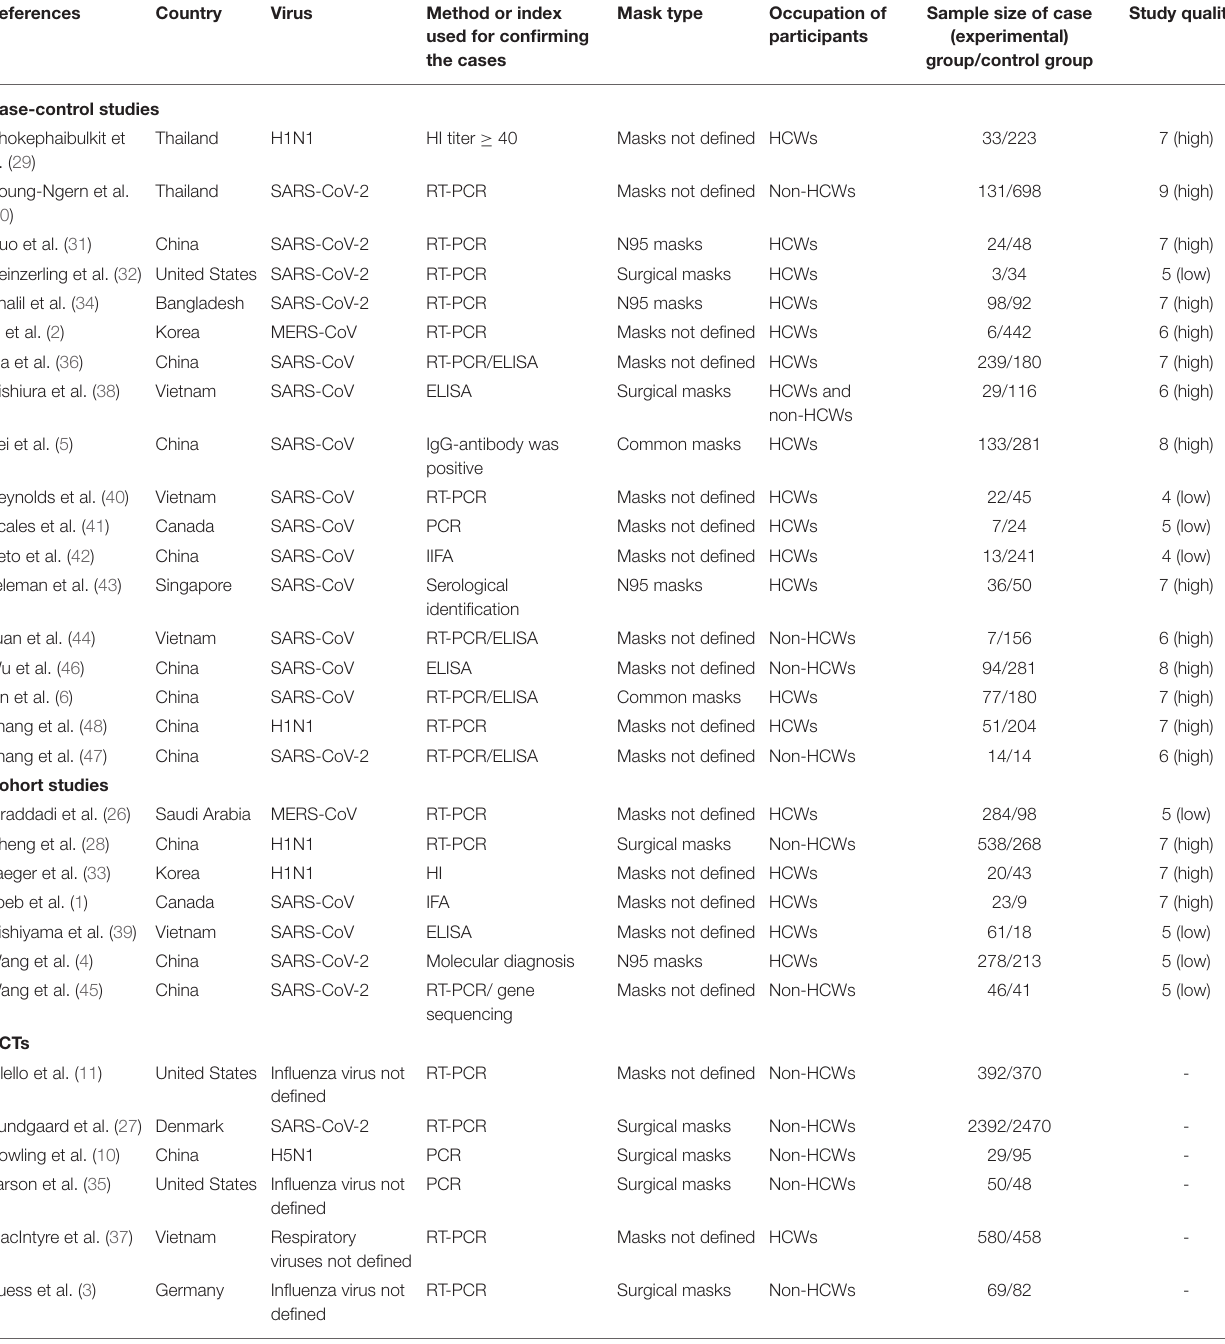
TABLE 1 | Characteristics of studies included in the